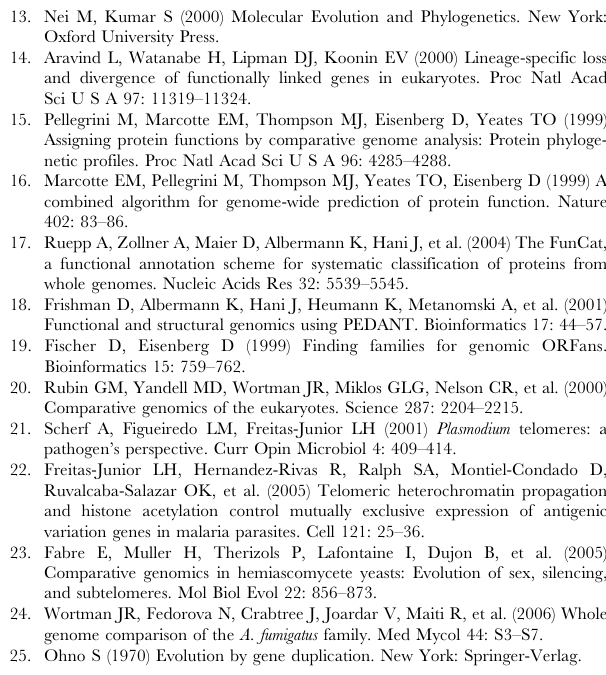
Table S1 Neurospora crassa genome information. N. crassa gene IDs, aliases, hyperlinks to MIPS database, MIPS descriptions, FunCat categories, Pfam domains, SignalP results, and LS classification for each of the % id threshold values are shown.